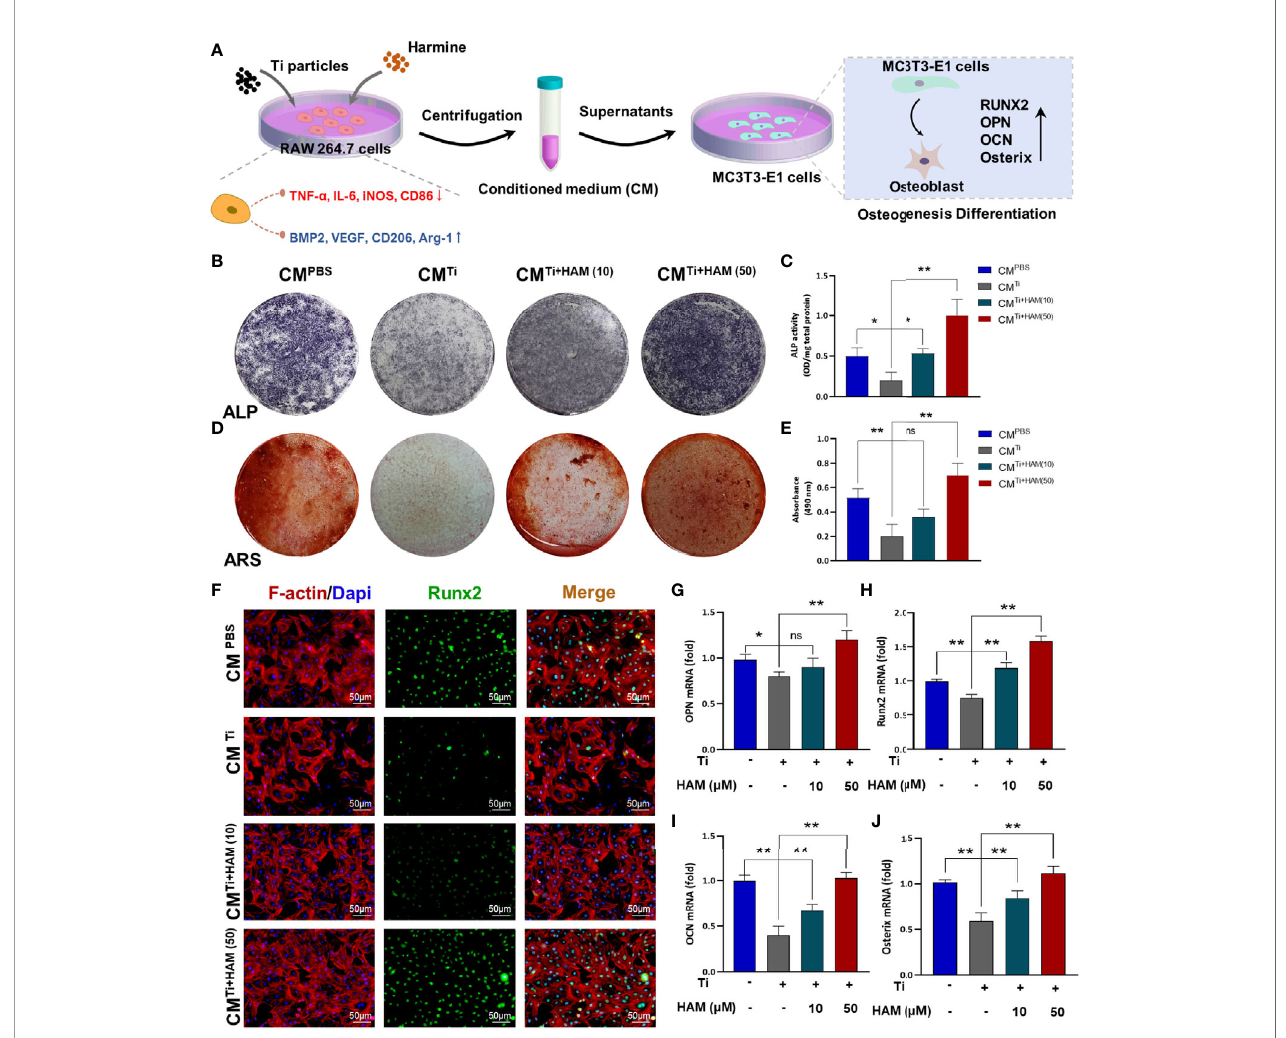
FIGURE 7 | The assessment of osteogenic differentiation ability in conditioned medium. (A) Pattern diagram. We used the supernatants of RAW264.7 cell culture as conditioned medium to assess immunomodulatory effect of harmine on osteogenic differentiation in MC3T3-E1 cells. (B) ALP staining assessed osteogenic differentiation of MC3T3-E1 cells in different groups. (C) ALP activity. (D) ARS staining for measuring mineralization of MC3T3-E1 cells from each group. (E) Absorbance at 490 nm. (F) Images of the MC3T3-E1 cells after coimmunostaining: red (actin rings), green (Runx2) and blue (nuclei). Scale bar indicates 50 m m. RT-PCR results for (G)